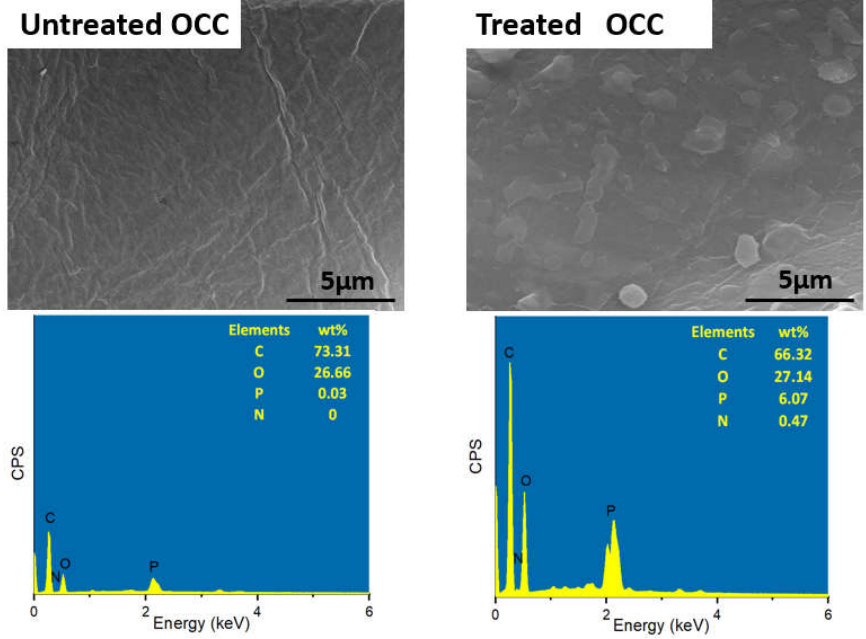
Figure 2. Images from SEM/EDS for the surface of OCC before and after modification.